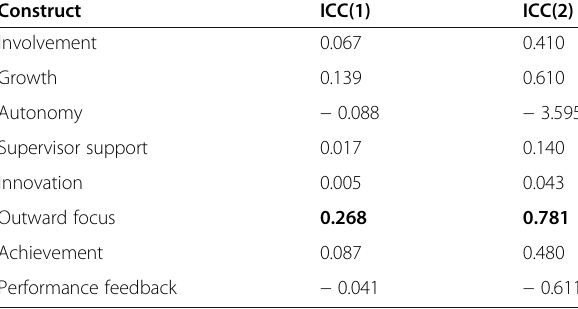
Table 8 ICC values. ICC(1) value interpretation: > 0.05 small to medium; > 0.25 large effect; ICC(2) value interpretation: < 0.4 poor; 0.40 – 0.75 fair to good; > 0.75 excellent. Values that